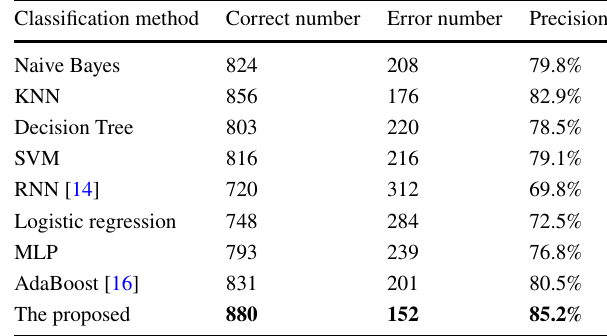
Table 5 Comparison of grouping and encoding